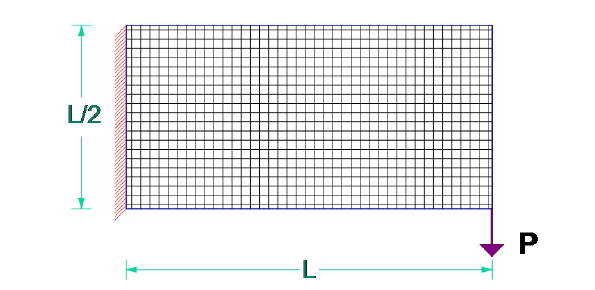
Figure 4. Creating density input